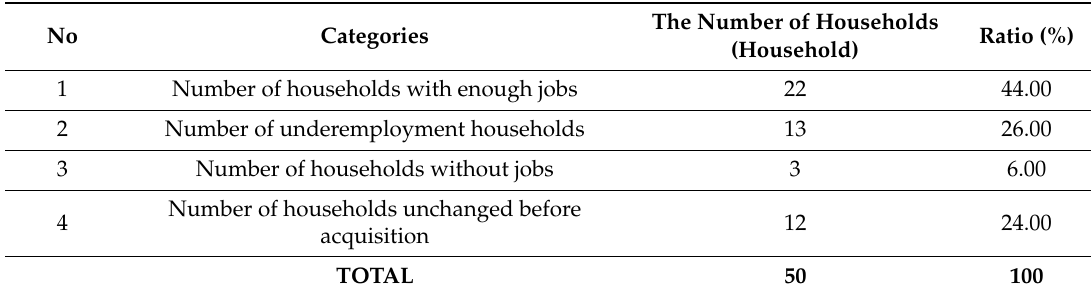
Table 3. Employment situation of households after land